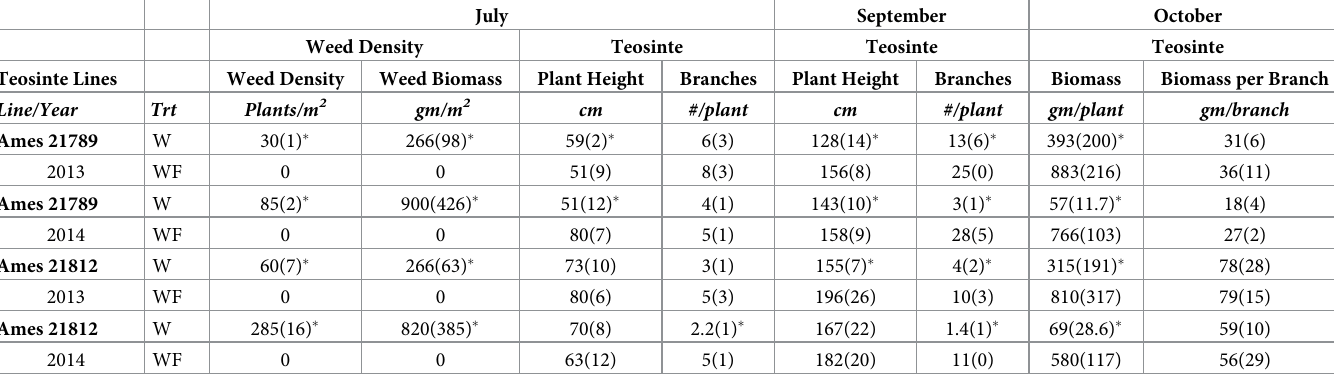
Teosinte response to weed pressure differed between years, as demonstrated by plant height, branch number and harvest biomass (Table 5). Teosinte plant height in July averaged 51 to 80-cm, and weedy/weed-free differences ranged from a height increase in weed stressed plants of 16% to a decrease of 36%. Ames 21789 demonstrated a 20% increase in weed-stressed plant height in 2013, whereas in 2014 this line was 45% shorter in weed-stressed conditions. Ames 21812 was similar in height under weed-free and weed-stressed conditions in 2013, but weed -stressed plants were 8% taller than the weed-free plants in 2014 (Table 5). Teosinte plant Table 5. Teosinte parameter averages for 2013 and 2014